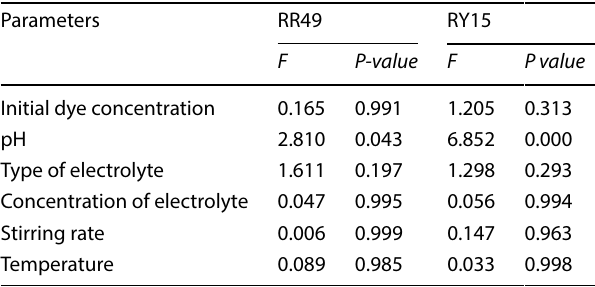
Table 5 the ANOVA test for RR49 and RY15 dyes Parameters